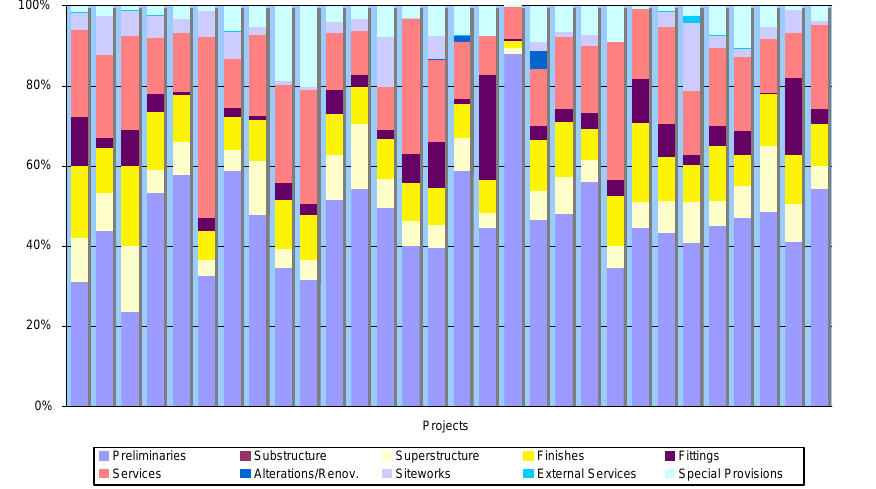
Figure 9: Distribution of Operating Cost by